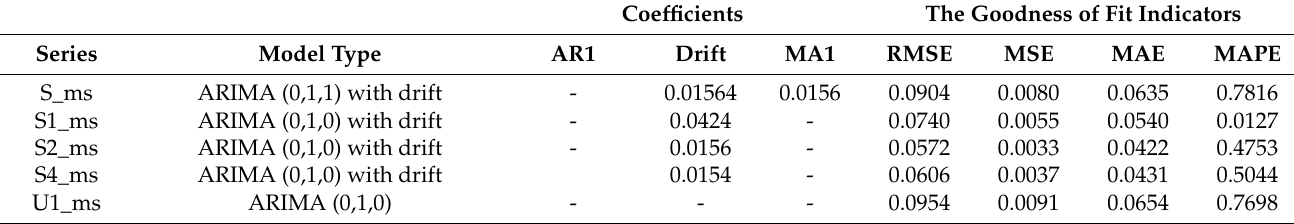
Table 20. ARIMA models for the monthly deseasonalized series.